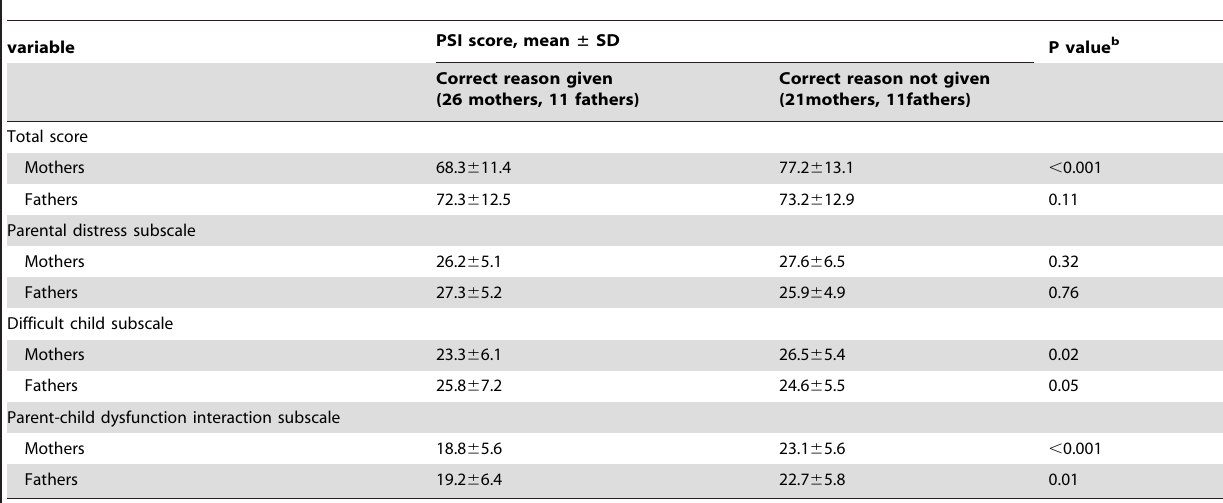
Table 4. PSI scores for parents in false-positive group according to self-reported reason for repeat screen. a